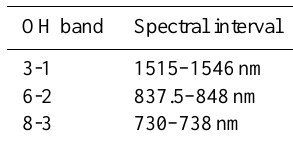
Table 1. Spectral windows used for the different OH Meinel